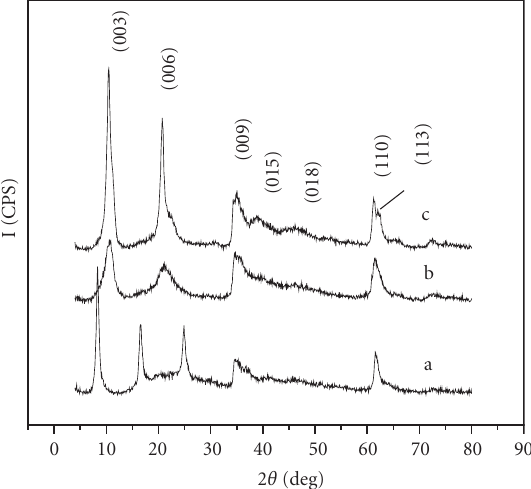
Figure 2: XRD powder patterns of the products prepared at di ff er- ent pH values a: 5.5, b: 8.5, c: